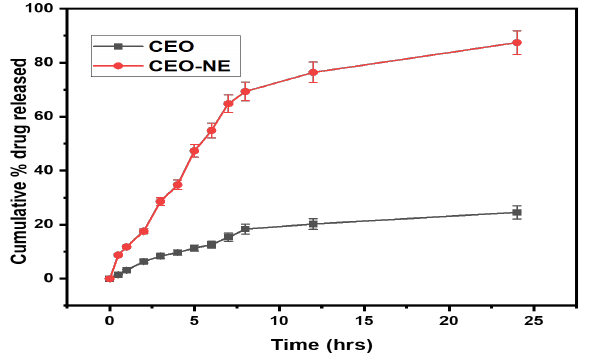
Figure 3. Comparative in vitro drug release study in pH 6.2 PBS solution for 24 h.